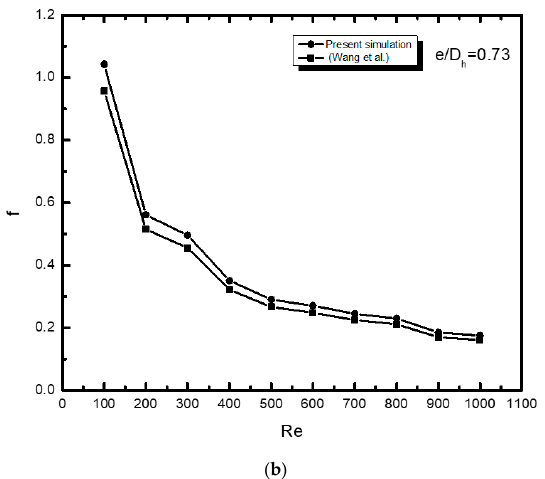
Figure 2. Validation of ( a ) Nusselt number and ( b ) friction factor with Wang et al. [21].